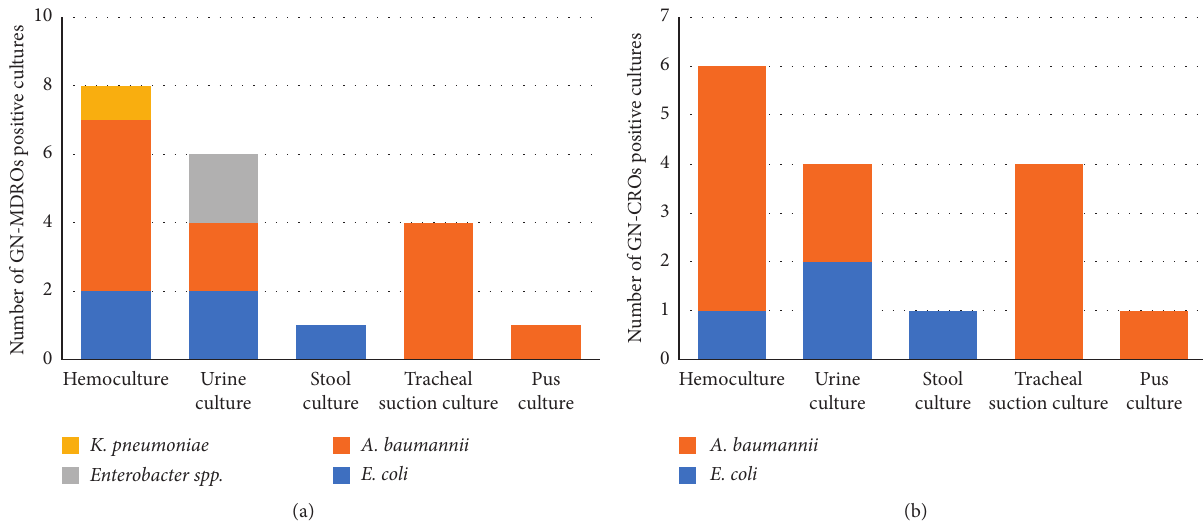
Figure 3: (a) Gram-negative multidrug-resistant microorganisms’ positive cultures according to infection sites ( N � 20). ∗ ∗ GN-MDROs, multidrug-resistant Gram-negative microorganisms. (b) Gram-negative carbapenem-resistant microorganisms’ positive cultures according to infection sites ( N � 16). ∗ ∗ GN-CROs, carbapenem-resistant Gram-negative